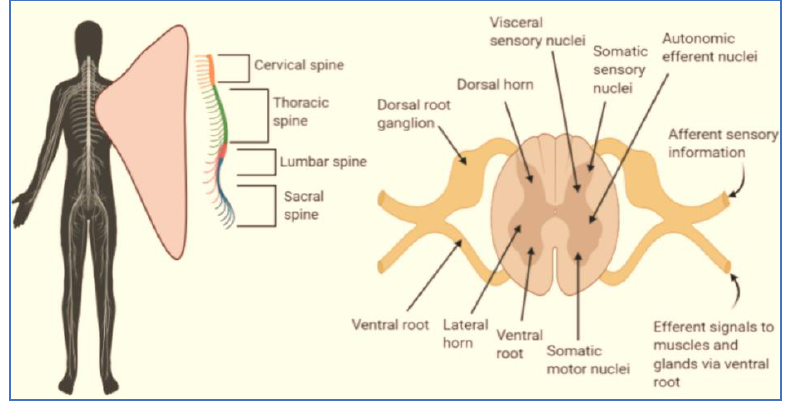
Figure 1. Human spine and the cross-section of the spinal cord [1].